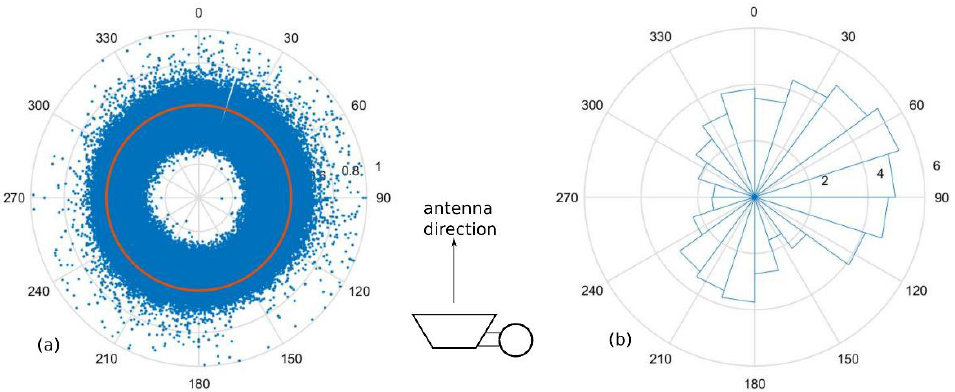
Figure 11. ( a ) Angle magnitude plot versus wind direction, with the threshold shown; ( b ) histogram of angle magnitudes that exceed threshold according to the wind direction (the number of samples ×1000). The antenna is facing 0°.